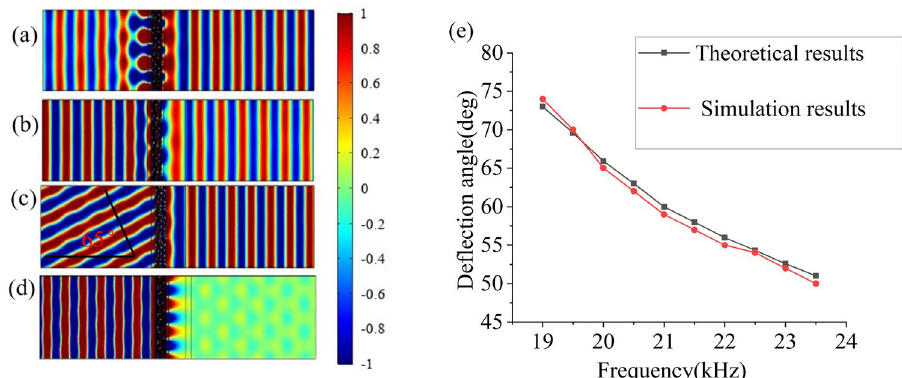
Figure 3. Spatial distribution of the acoustic pressure generated by the incident plane waves propagating along PD ( a ) and ND ( b ) at 17500 Hz, PD ( c ) and ND ( d ) at 20000 Hz. ( e ) Comparison of theoretical and simulated results from 19 to 23.5